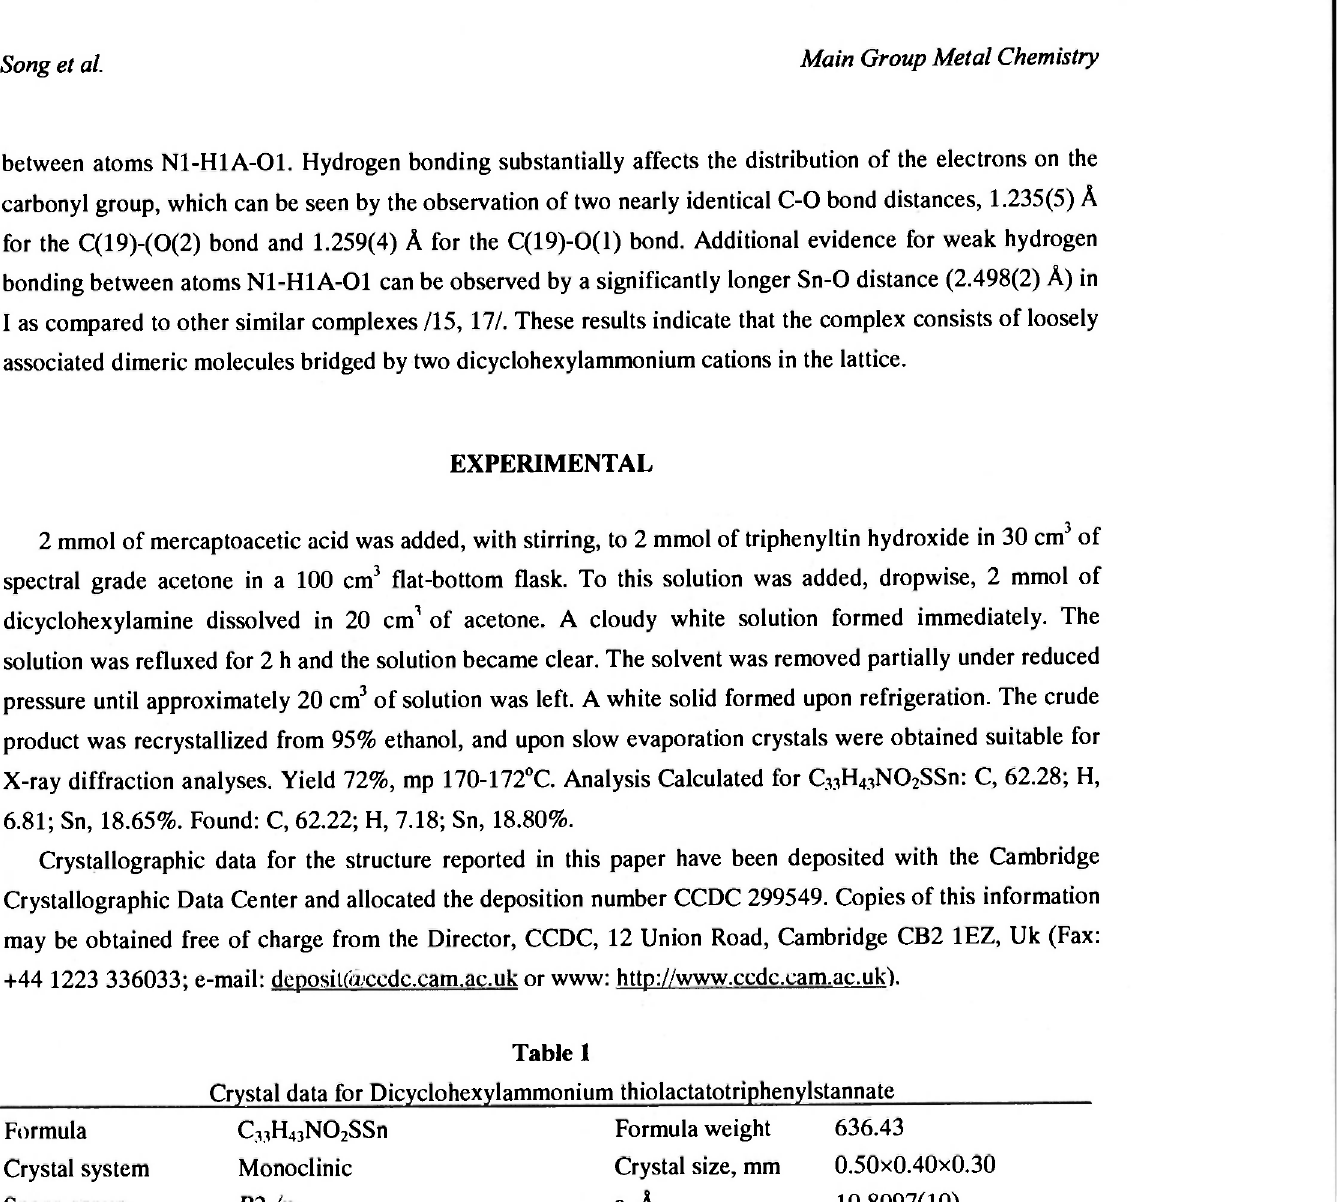
Crystal data for Dicyclohexylammonium